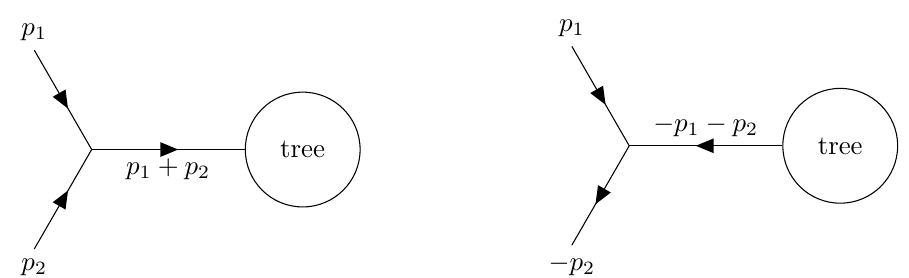
Figure 5 . These diagrams are responsible for the holomorphic collinear singularities of tree form factors in SD Yang-Mills, and tree amplitudes in 1 st -order deformations of SD gravity. Since the tree amplitudes in both SD Yang-Mills and SD gravity are trivial, the blob labelled ‘tree’ must involve the local operator or deformation. The collinear singularities are therefore